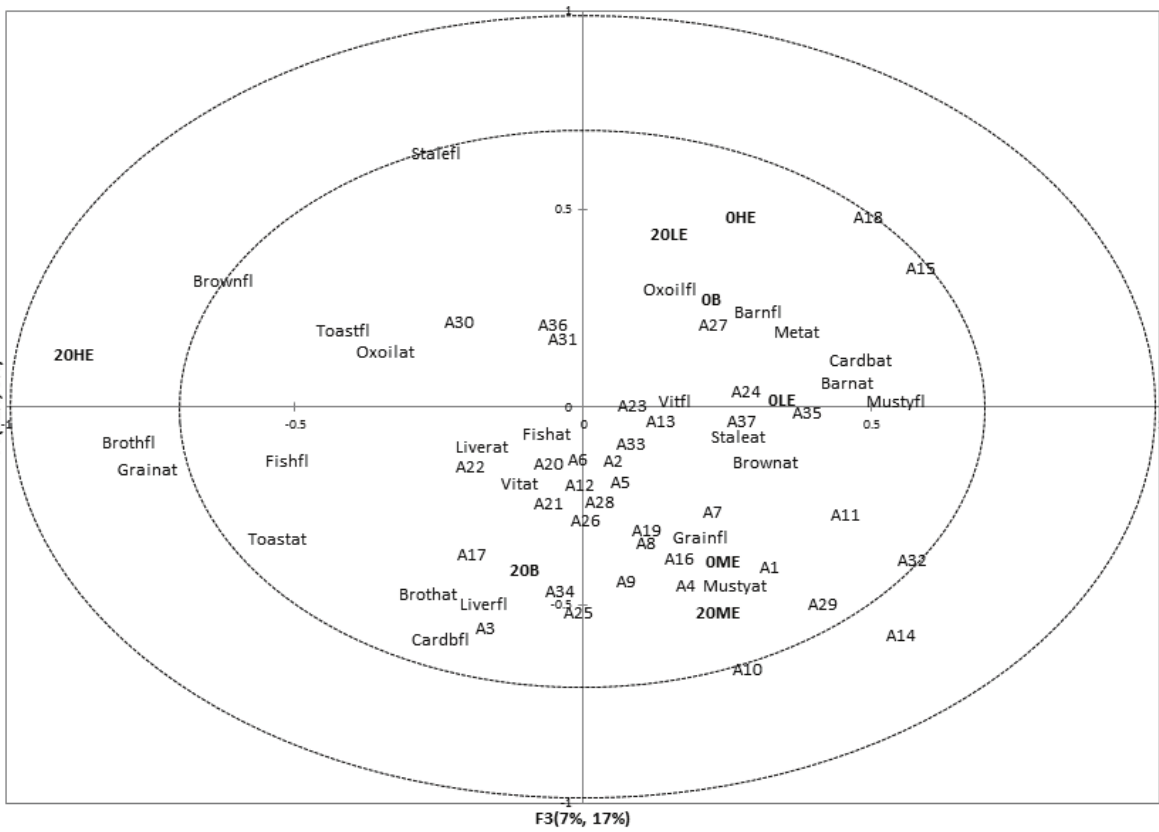
Figure 3. Partial Least Squares Regression Factors 3 and 4. Suffixes: ap – appearance; ar – aroma; fl – flavor; at –